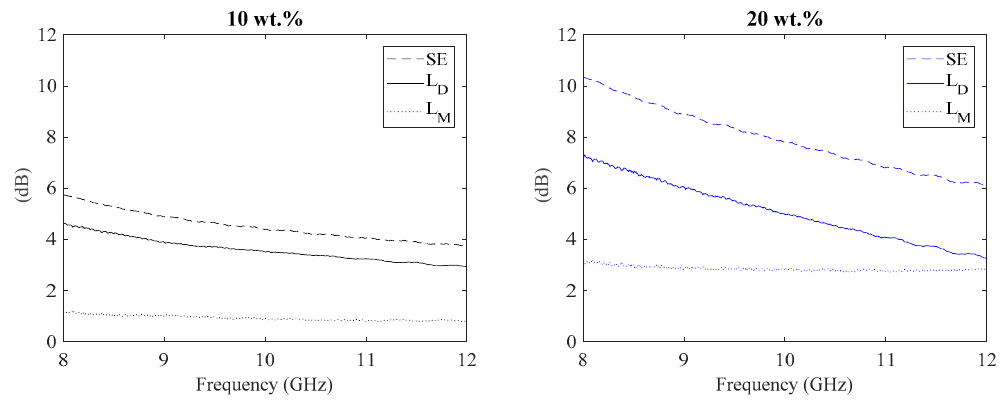
Figure 10. Total shielding effectiveness and dissipation loss.